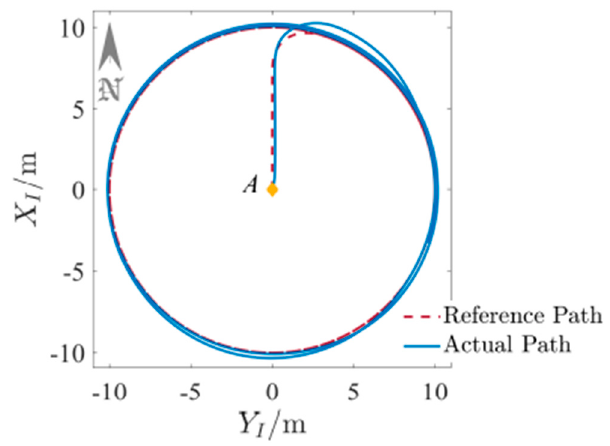
Figure 26. Route diagram of circular tracking based on the ATD guidance law.